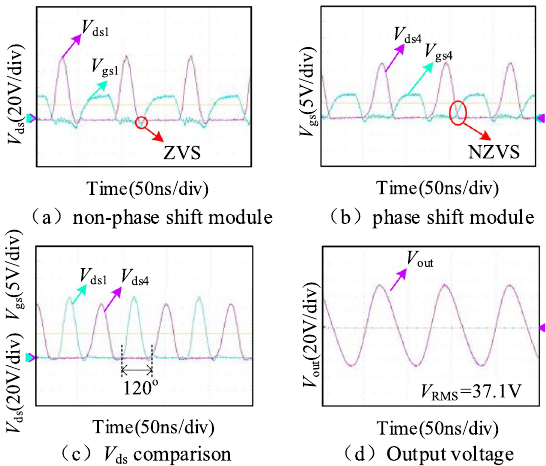
Fig. 14 Working waveforms with phase shift of 120°